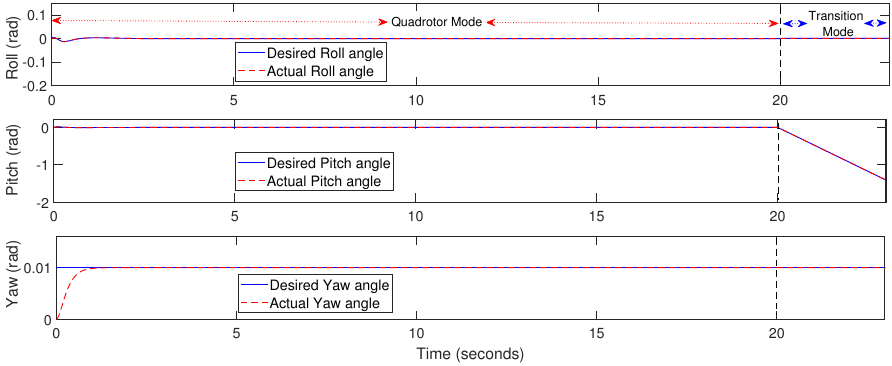
Figure 6. Attitude tracking during quadrotor mode and transition mode.